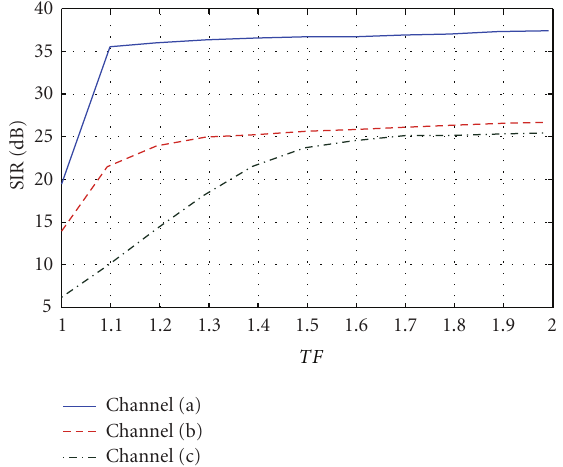
Figure 3: Average signal-to-interference ratio as a function of TF